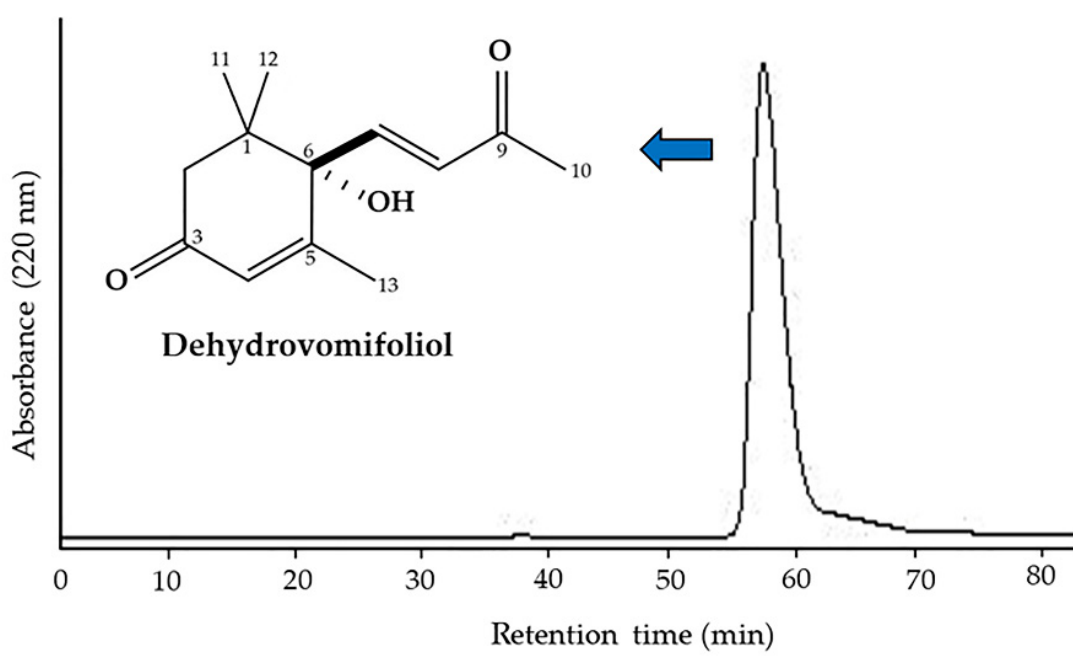
Figure 3. HPLC chromatogram and chemical structure of dehydrovomifoliol. Figure 1. HPLC chromatogram and chemical structure of dehydrovomifoliol. The molecular formula of substance 2 was determined to be C 11 H 16 O 3 using ESIMS at m/z 197.1293 [M+H] + (calcd for C 11 H 17 O 3 , 197.1178). The 1 H NMR (400 MHz, CD 3